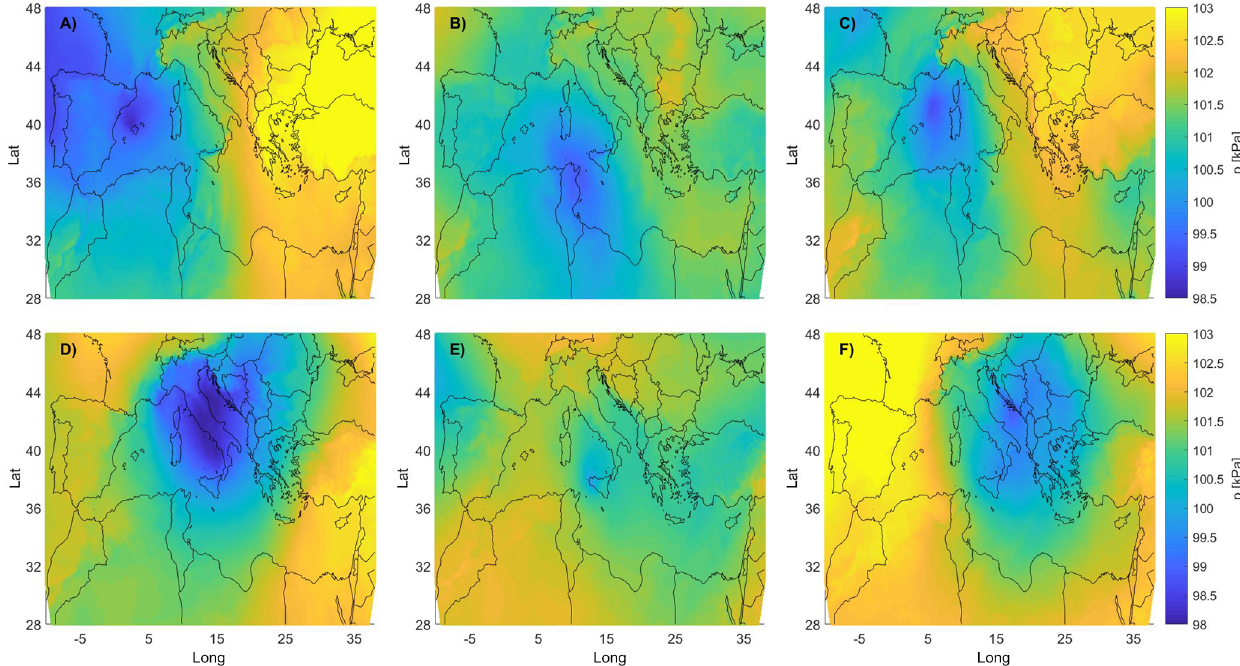
Figure 5. MSLP associated with the three highest POT events in Mazara del Vallo (B4). (a–c) WP#1 events; (d–f) WP#2 events. The storms are sorted from left to right in descending order.